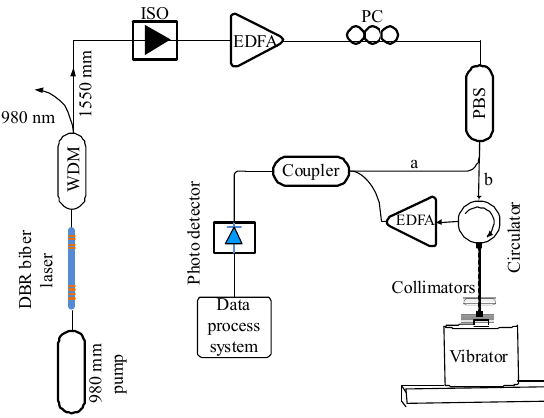
Fig. 1 Experimental setup: WDM: wavelength division multiplexer; ISO: isolator; EDFA: erbium-doped fiber amplifier; PC: polarization controller; PBS: polarization beam